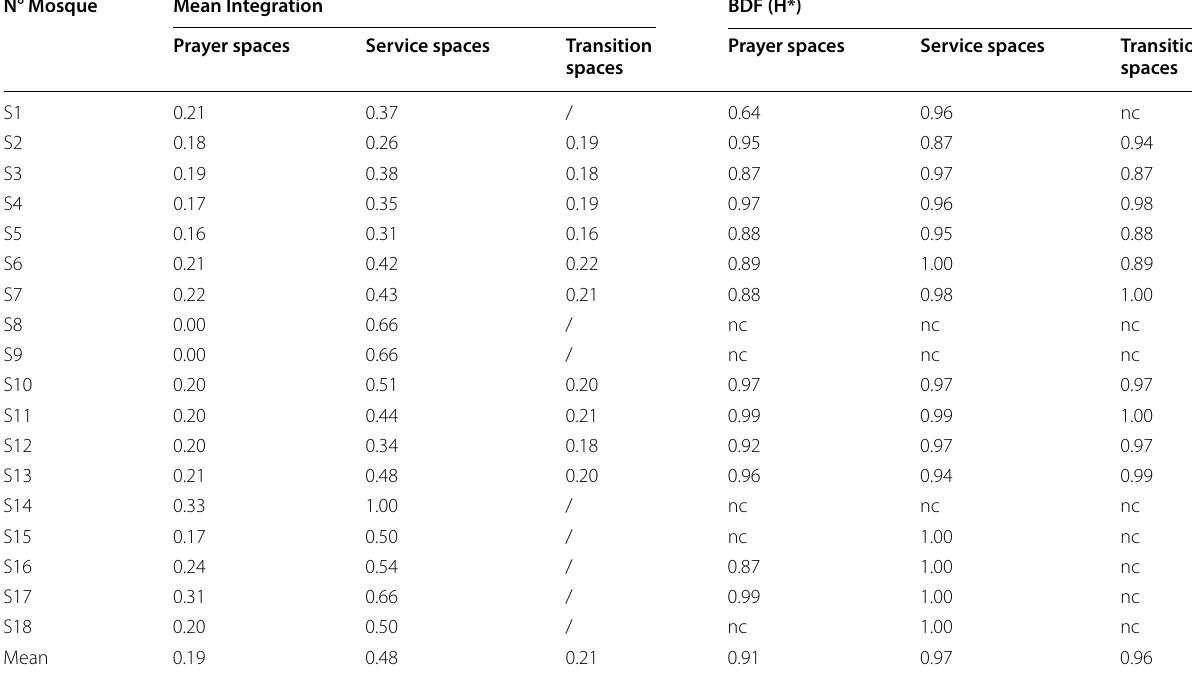
nc not calculated An interior difference factor was not calculated because there were only two types of interior space in this mosque or the absence of this type of space